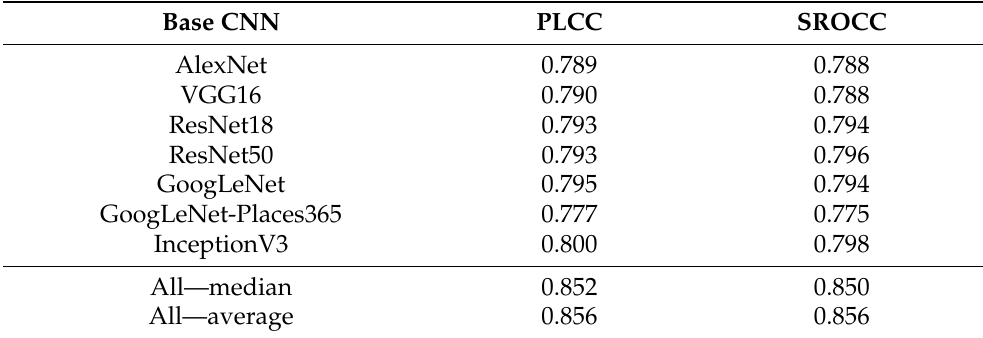
Table 8. Performance of different base architectures and decision fusion methods using SWGAP layers for feature extraction and GPRs with rational quadratic kernel function for regression. Median PLCC and SROCC were measured over 1000 random train–test splits.